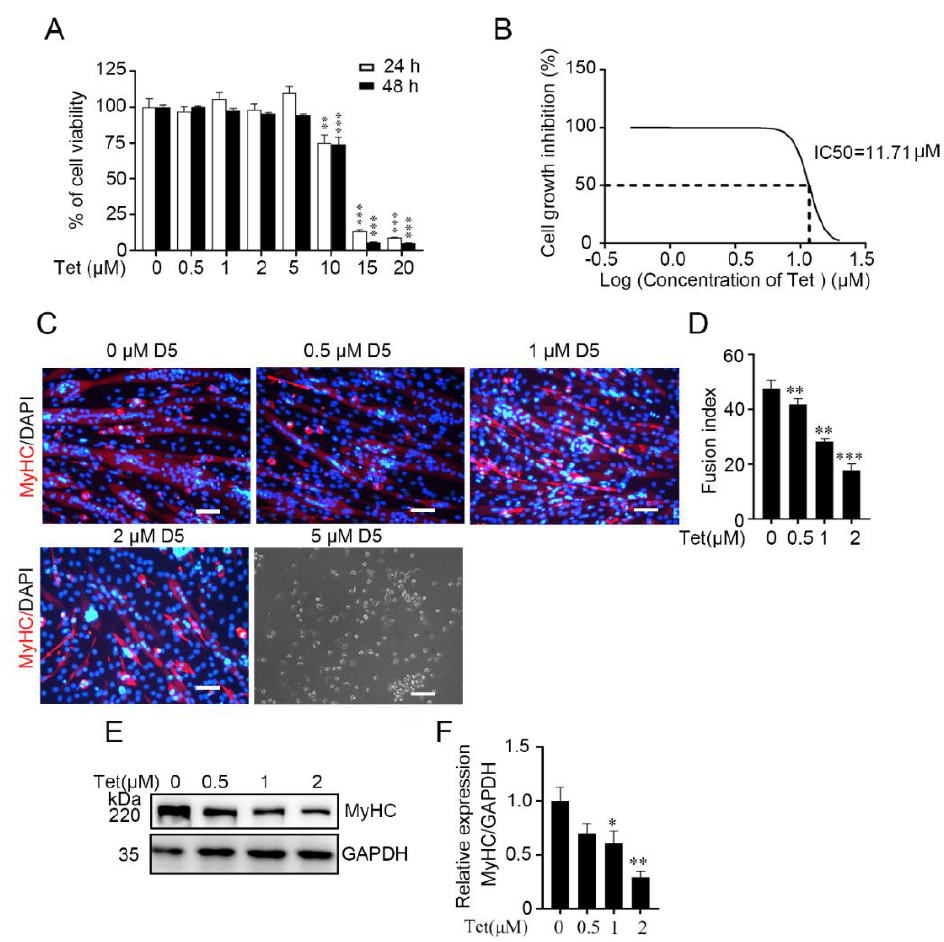
Figure 1. Tetrandrine inhibits myogenic differentiation in C2C12 myoblasts. ( A ): An MTT assay was performed to measure the cytotoxic effect of tetrandrine on C2C12 myoblasts. n = 3, ** p < 0.01 and *** p < 0.001. ( B ): The IC50 of tetrandrine on C2C12 cells was calculated. ( C ): C2C12 myoblasts were differentiated for 5 d in DM with or without tetrandrine and immunostained with anti-MyHC (MF20) (red). The nuclei were counterstained with DAPI (blue). ( D ): The fusion index in C was determined. n = 3, ** p < 0.01 and *** p < 0.001. Scale bars: 50 µ m. ( E ): Representative Western blots showing the expression of MyHC in C2C12 myoblasts after 5 days of differentiation (D5). ( F ): The relative expression of MyHC in E was quantified. n = 3, * p < 0.05 and ** p < 0.01. Tet, tetrandrine; MyHC, myosin heavy chain; GAPDH, Glyceraldehyde-3-phosphate dehydrogenase; IC50, half maximal inhibitory